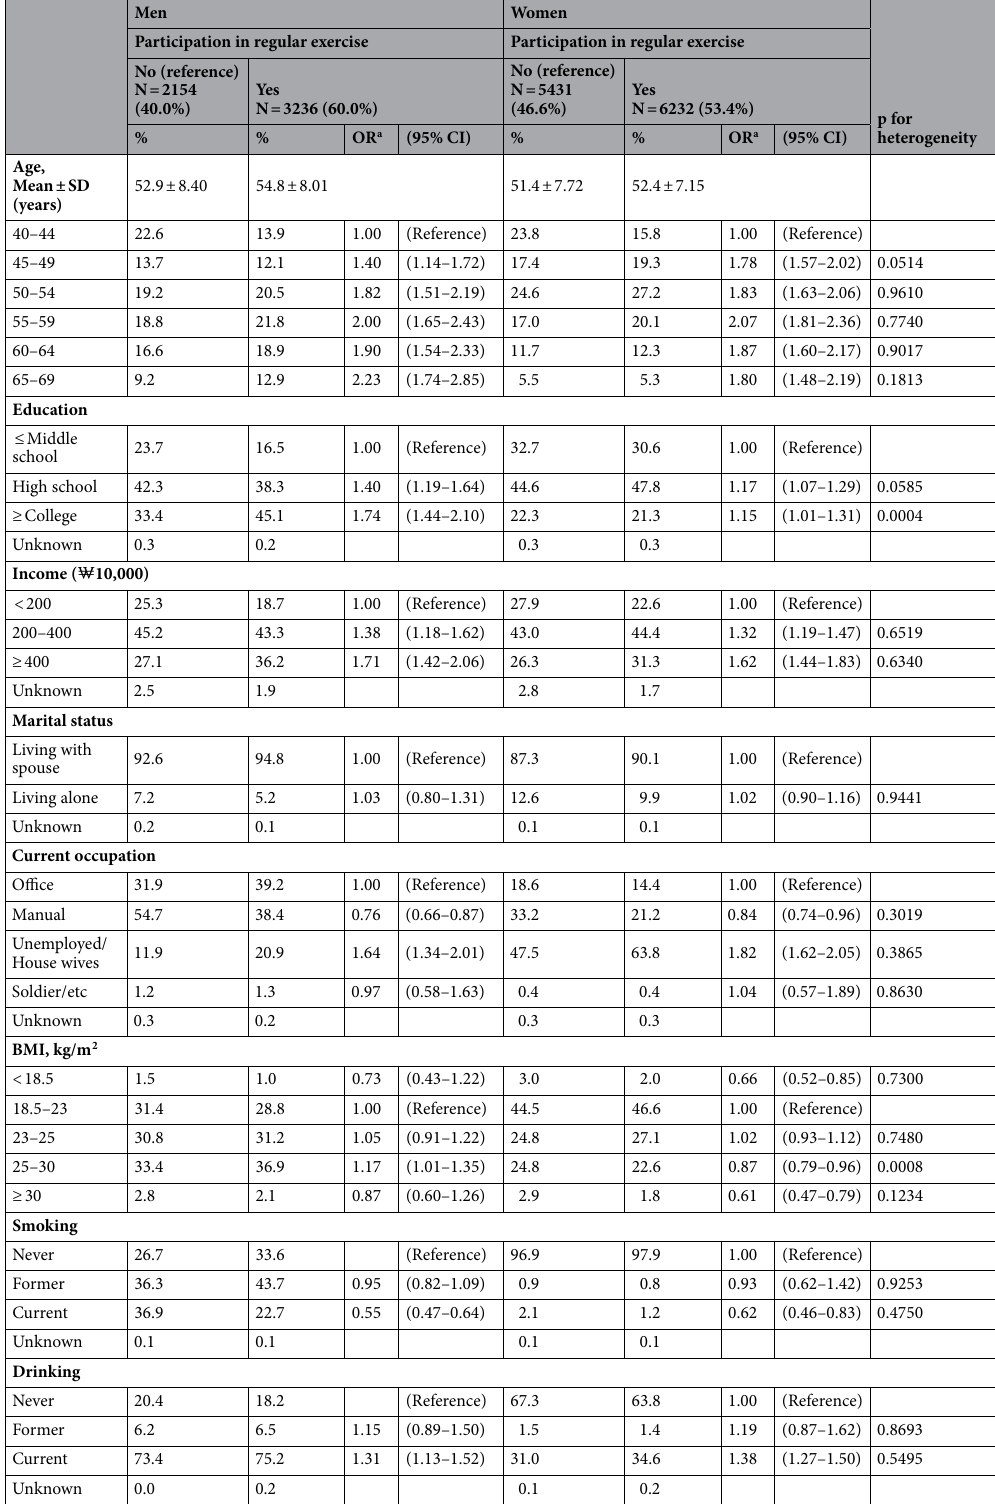
Table 1. Characteristics of the study population at baseline according to participation in regular exercise. a Adjusted for age, education, income, marital status, job, BMI, smoking status, and drinking